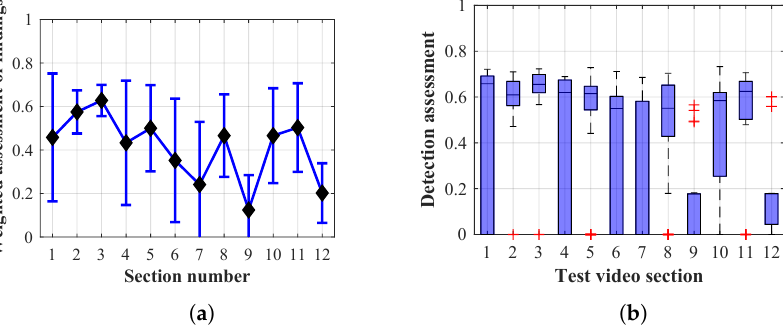
Figure 42. Results of Method 2.3 with a lifespan of 1 frames. ( a ) the weighted average rating with the average mean absolute error of the weighted rating and ( b ) boxplots of the distribution of the statistical sets of the results of the individual sections evaluated indicating: minimum, 1st quartile, median, 3rd quartile, maximum.